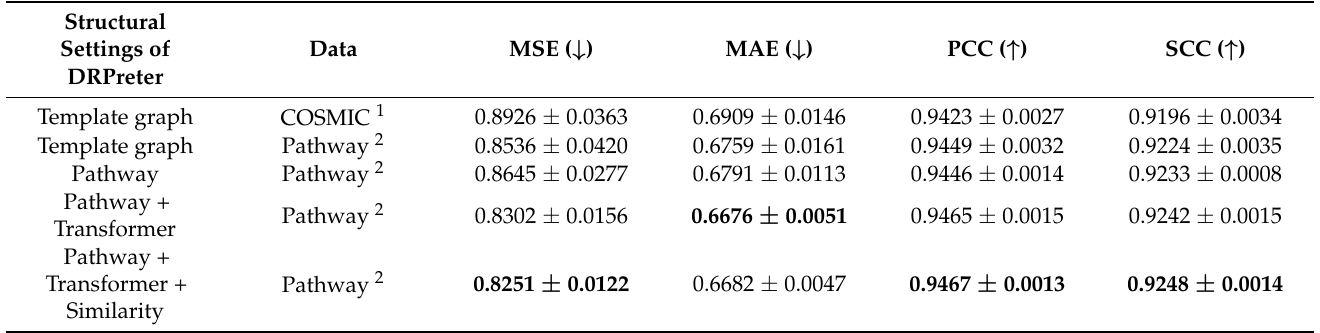
Table 1. Model ablation studies with different settings.